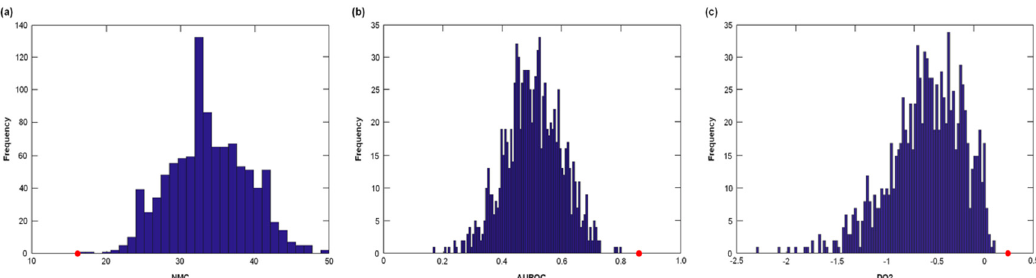
Figure 2. Distribution of ( a ) number of misclassifications (NMC), ( b ) area under the receiver operating characteristic (ROC) curve (AUROC), and ( c ) discriminant Q2 (DQ2) values under their respective null hypothesis as estimated by permutation tests (blue histograms) and the corresponding values obtained by the PLS-DA model on unpermuted data (red circles). Values obtained on the real dataset (red circles) fall outside of the corresponding null hypothesis distribution (blue histograms), corresponding to a p < 0.05.